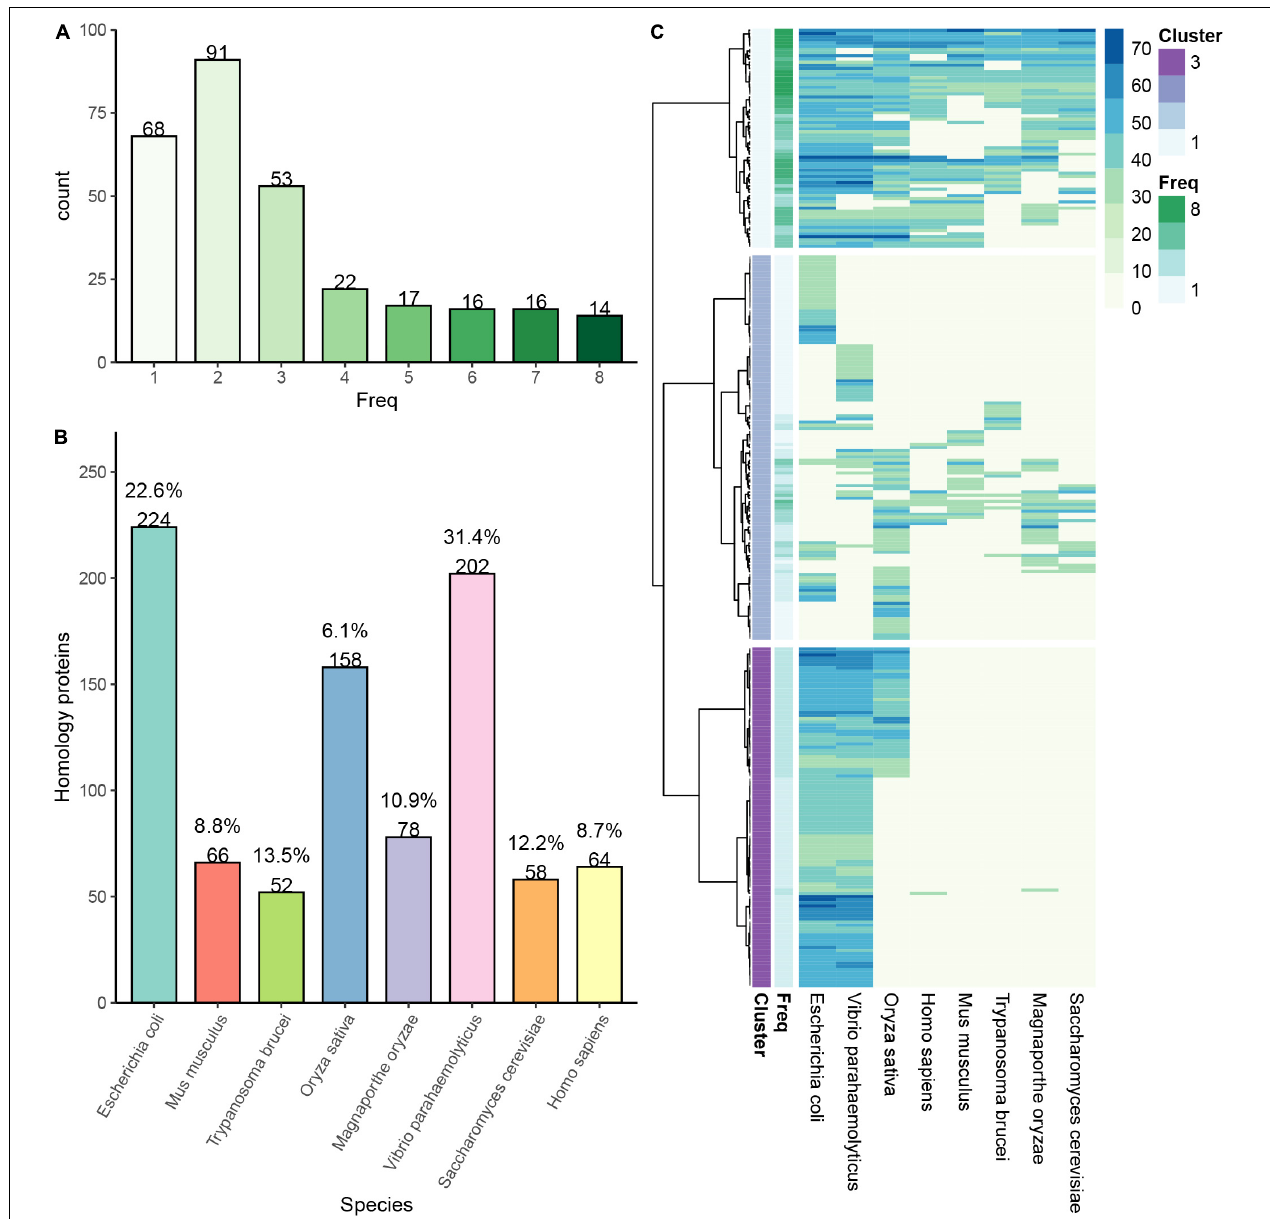
FIGURE 2 | Conservation analysis of identified succinylation proteins in Staphylococcus epidermidis. (A) The number of proteins in S. epidermidis with a different frequency of homology in various organisms. (B) The number and percentage of proteins in 8 different species, which are homologous with those in S. epidermidis. (C) Cluster proteins in S. epidermidis are classified into three categories according to their frequency of homology with other 8